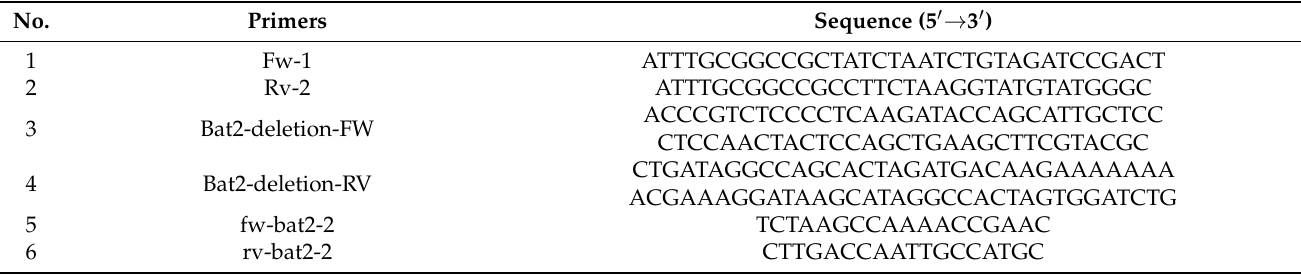
Table 1. Primers used in this